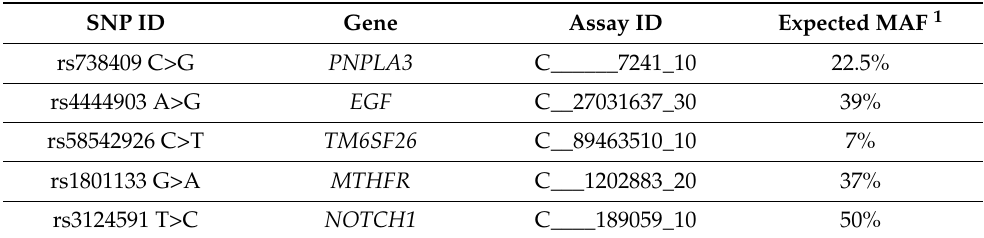
Table A1. Assay IDs and expected minor allele frequency for the selected single-nucleotide polymor-